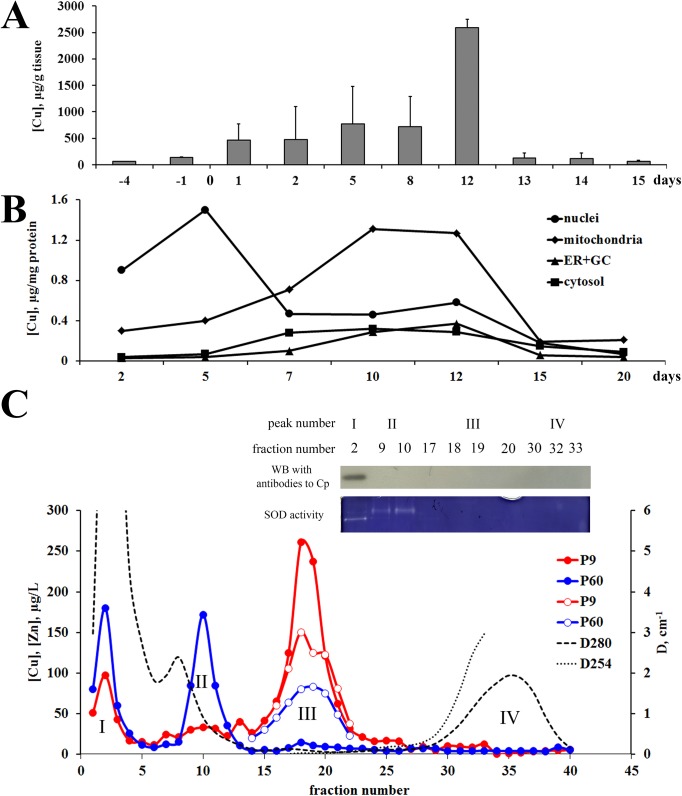
Hepatic copper concentration and copper distribution in the liver cells of newborn rats.(А) Copper is accumulated in the liver from embryonic stage development to 12
th
day of life. Ordinate axis: hepatic copper concentrations, μg/g wet weight (the means ± SD, n = 5); abscissa axis: age, days. (B) During accumulation copper is redistributed between subcellular compartments. Each dot represents the average from 3 experiments, in which the differences were not more than 10%. For each point, depending on the age of rats, 2–10 livers were combined to isolate subcellular fractions (nuclei–circle, mitochondria–rhomb, (endoplasmic reticulum + Golgi complex)–triangle, cytosol–rectangle). Ordinate axis: copper concentrations, μg/mg total protein; abscissa axis: age, days. (C) Gel-filtration distribution of copper in cytosol of the newborn (P9, red) and adult (P60, blue) rats. Cytosolic fraction was isolated from about 1 g liver tissue (a mixture of ∼350 mg of liver tissue from three rats) as described in Methods. Ordinate axis (left): copper (closed dots) or zinc (open dots) concentration, μg/L, Arrow shows eluted position of cytochrome C. Ordinate axis (right): optical density–D280 (dotted line) and D254 (dots). Abscissa axis: fraction number. Inset: WB with antibodies to ceruloplasmin (8% SDS-PAGE) and SOD activity (gel-test, 8% PAGE); the samples content 10 μl of the major copper fractions from peaks I, II, III, and IV of P9 cytosol.